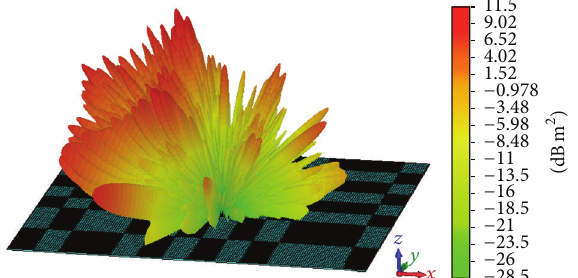
Figure 18: 3D plot of the bistatic RCS pattern at 17GHz for (𝜃 inc = 30 ∘ , TE ) .